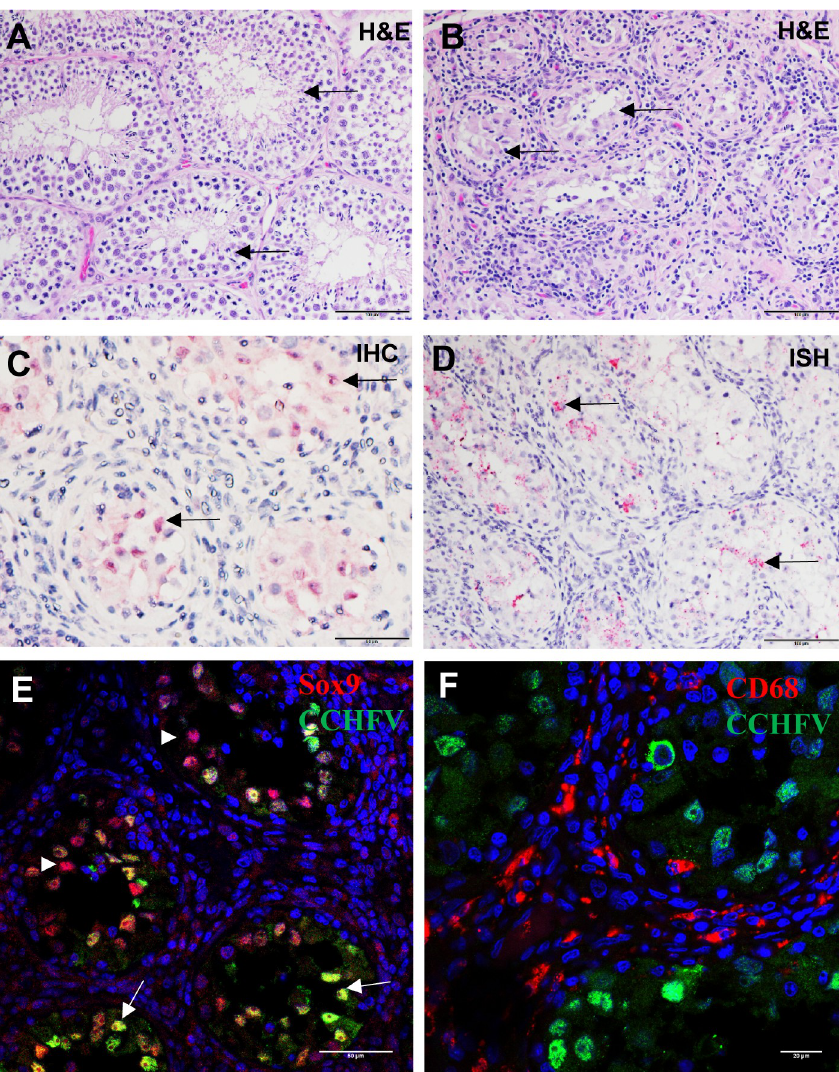
Fig 3. Histologic, IHC, and ISH findings in the testes of CCHFV-infected cynomolgus macaques. A). Hematoxylin and eosin staining of an animal with a normal appearing testis and no evidence of CCHFV infection. Arrow, seminiferous tubules. B). Hematoxylin and eosin staining of an animal with inflammation of the testis. Arrow, seminiferous tubules. C). IHC staining demonstrating positive (red) staining of presumed Sertoli cells in an area of inflammation in the testis of an infected animal. Arrow, CCHFV antigen-positive cells. D). ISH staining demonstrating that CCHFV RNA is detected in the luminal debris and Sertoli cells in the testis of a CCHFV-infected animal. Arrow, CCHFV RNA-positive Sertoli cells. E) IFA demonstrating that CCHFV (green) infects Sertoli cells (red). White arrowheads indicate CCHFV negative Sertoli cells labeled by an anti-Sox9 antibody while arrows indicate CCHFV positive Sertoli cells labelled by an anti-Sox9 antibody. F). IFA demonstrating that CCHFV (green) does not infect CD68 + macrophages/monocytes (red) in the testis. seminiferous tubules, which is the site of sperm production and an immune privileged area of the body. To determine the location of the viral antigen, we performed immunofluorescence (IFA) staining using an antibody against Sox9, which is an established cell-specific marker for Sertoli cells. IFA demonstrated that CCHFV specifically infects Sertoli cells and not CD68 + macrophages/monocytes in the testis (Fig 3E and 3F).